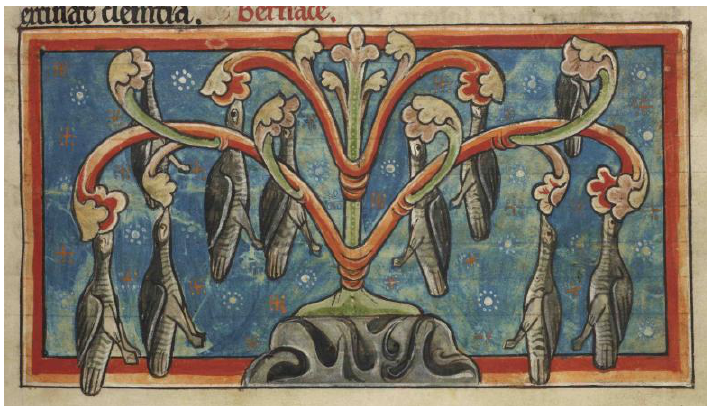
Figure 1. Bernace or barnacle-geese as described by Gerald of Wales (Giraldvs Cambrensis circa 1146–1223): Bernace develop from beams in the water and hang from trees enclosed in shells until they can grow feathers and fly . This Bestiary is held in the British Library collection, Harley MS 4751, Folio 36r; image produced in England, possibly at Salisbury; dated 1235